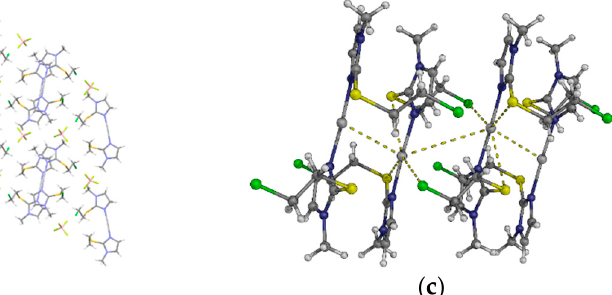
Figure 8. ( a ) Molecular structure of 6 with the atomic numbering scheme; ( b ) projection of 6 down the crystallographic a axis; ( c ) part of the crystal structure 6 : close contacts between silver(I) ions and neighboring atoms.